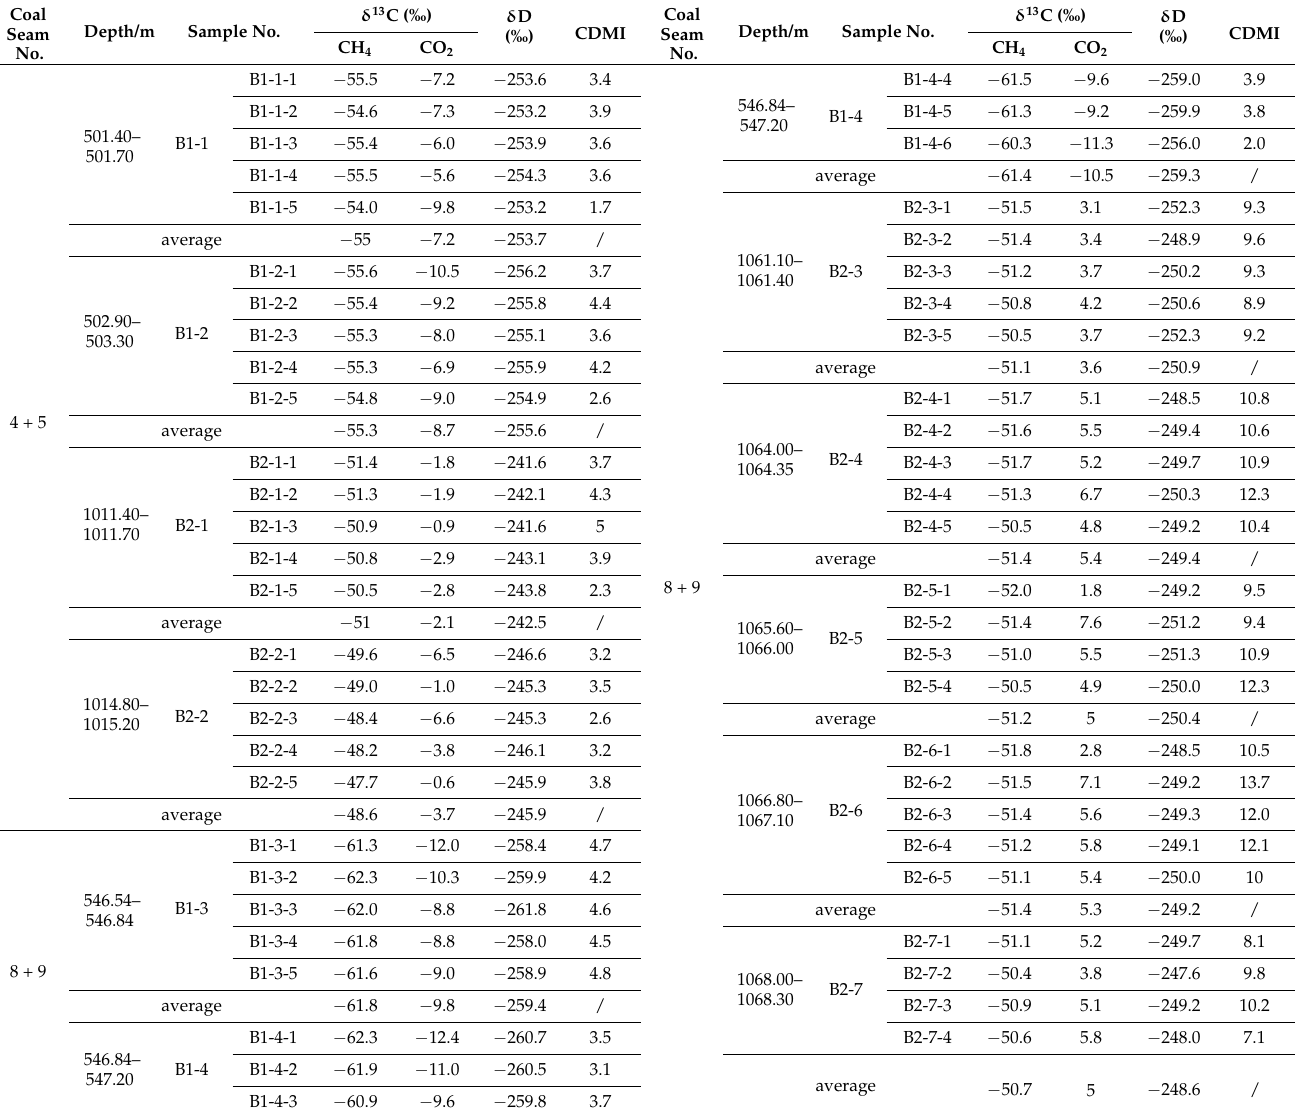
Table 3. Carbon and hydrogen stable isotope compositions and CDMI values of gas samples from eleven desorption tanks in different desorption